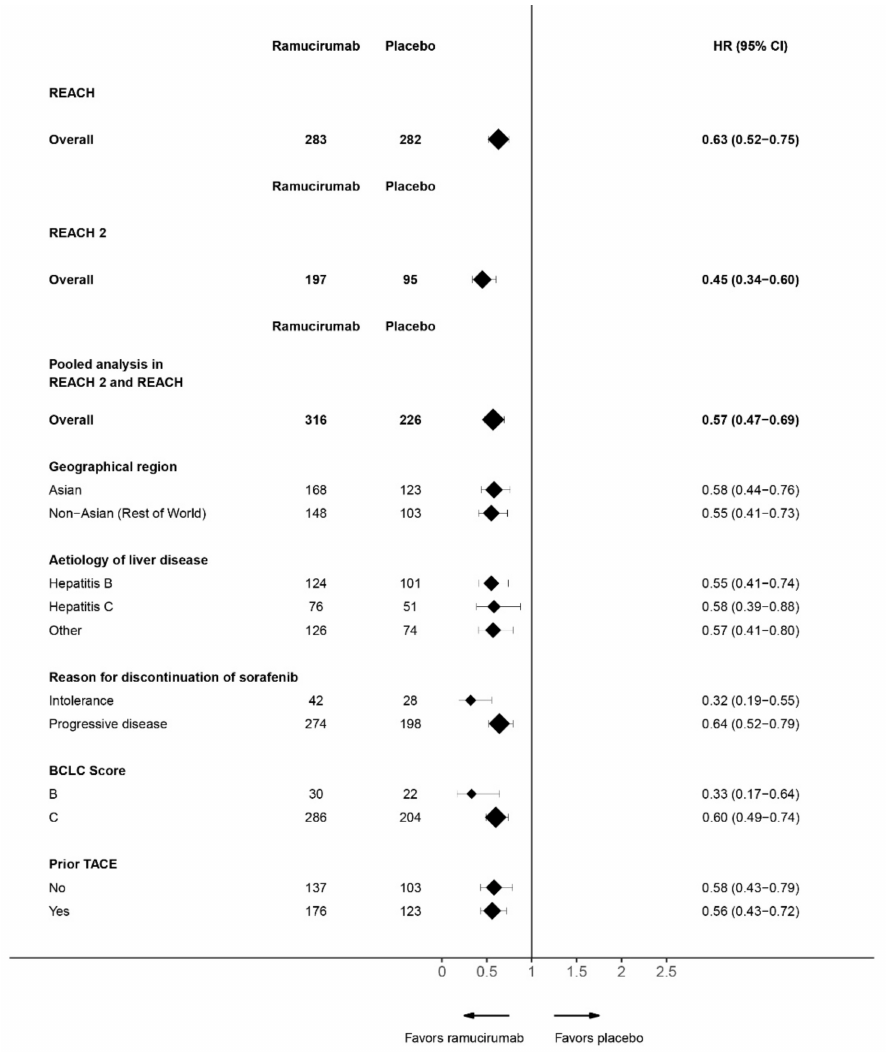
Figure 1. Forest plots for subgroup analyses of ( a ) overall survival (OS) and ( b ) progression-free survival (PFS) in the randomized controlled trails (RCTs) of ramucirumab in gastrointestinal (GI] cancers. Hazard ratios (HR] and 95% confidence intervals (CI) have been calculated using a stratified Cox model unless indicated with an asterisk (*) where an unstratified Cox model was used. The